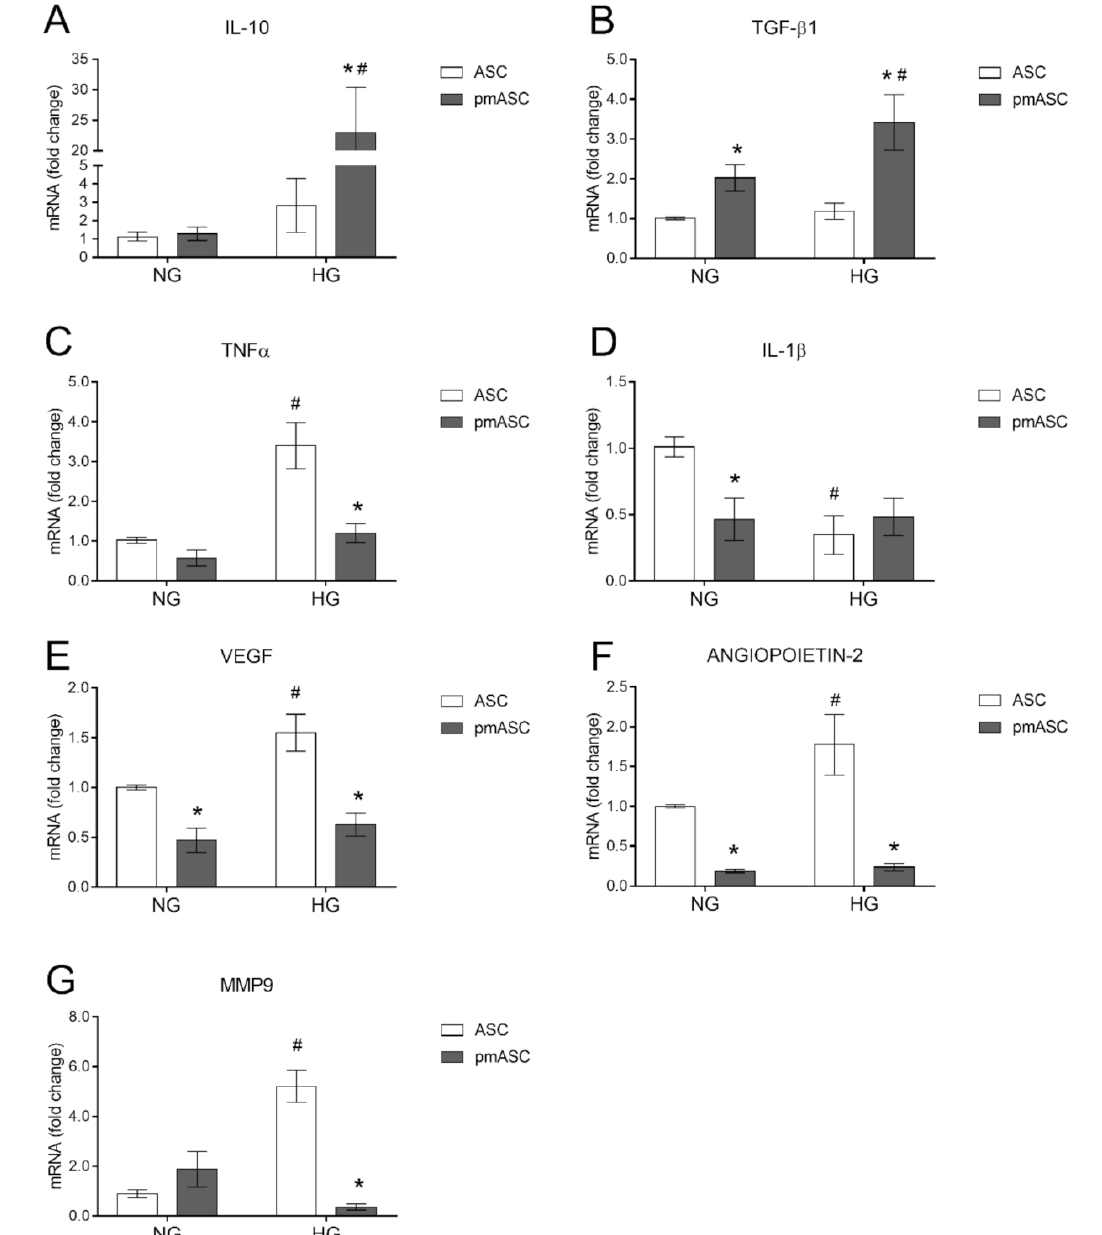
Figure 5. High glucose effects on anti- and pro-inflammatory cytokines and angiogenic factors in human adipose mesenchy- mal stem cells cultured in basal medium (ASC) or in pericyte medium (pmASC). In some samples, glucose was added to the culture medium (High Glucose, 25 mM, HG); data were gathered after 72 h from glucose addition and compared to corresponding samples kept in normal glucose (NG) condition. Quantitative analysis of IL 10 ( A ), TGF- β 1 ( B ), TNF α ( C ), IL-1 β ( D ), VEGF ( E ), Angiopoietin-2 ( F ) and MMP9 ( G ) mRNA levels, as evaluated by qRT-PCR. mRNA levels of each group were normalized to the housekeeping reference gene ribosomal 18S RNA. In the histograms, values are expressed as a fold change of those detected in ASCs cultured in NG condition. Each value represents mean ± SEM obtained from three independent experiments. * p < 0.05 pmASC vs. ASC; # p < 0.05 HG vs. NG. Two-way ANOVA, followed by Sidak’s